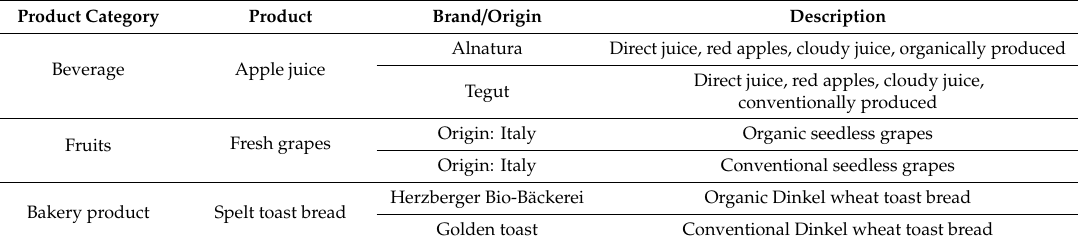
Table 3. The product information on the six food stimuli.